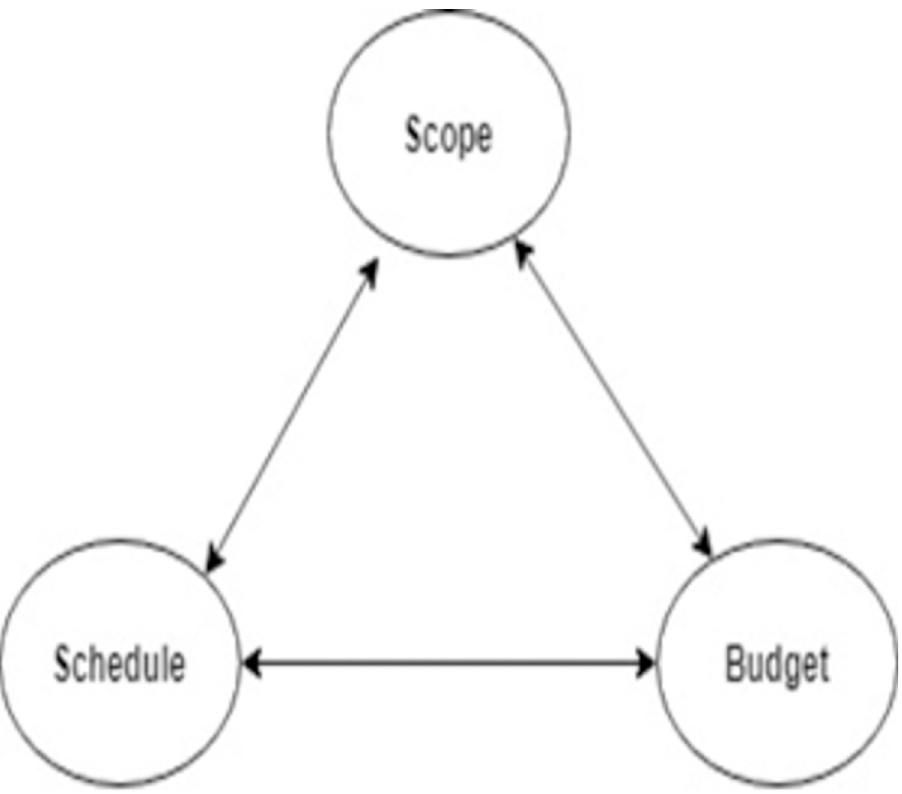
Fig 3. First triangle of PMBOK six-pointed star framework